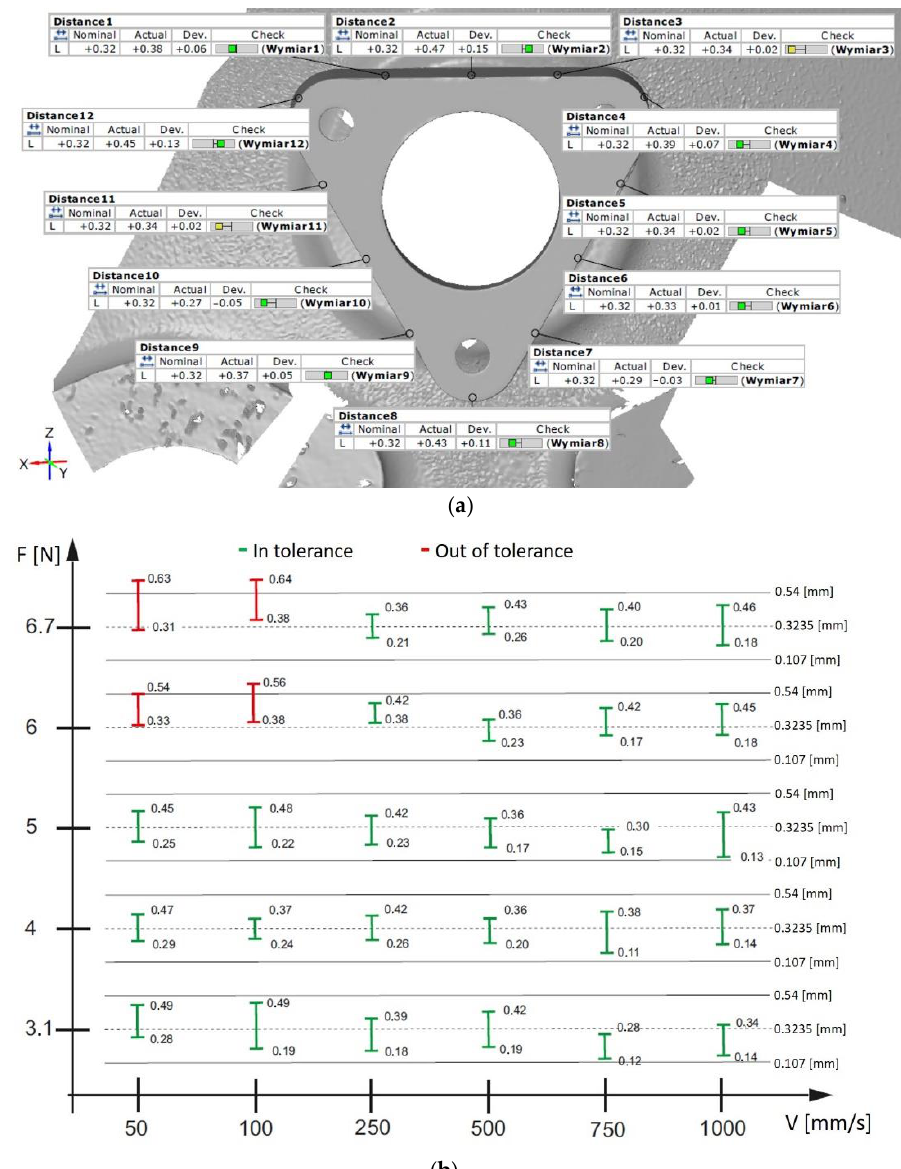
Figure 7. ( a ) Exemplary measurement report; ( b ) research